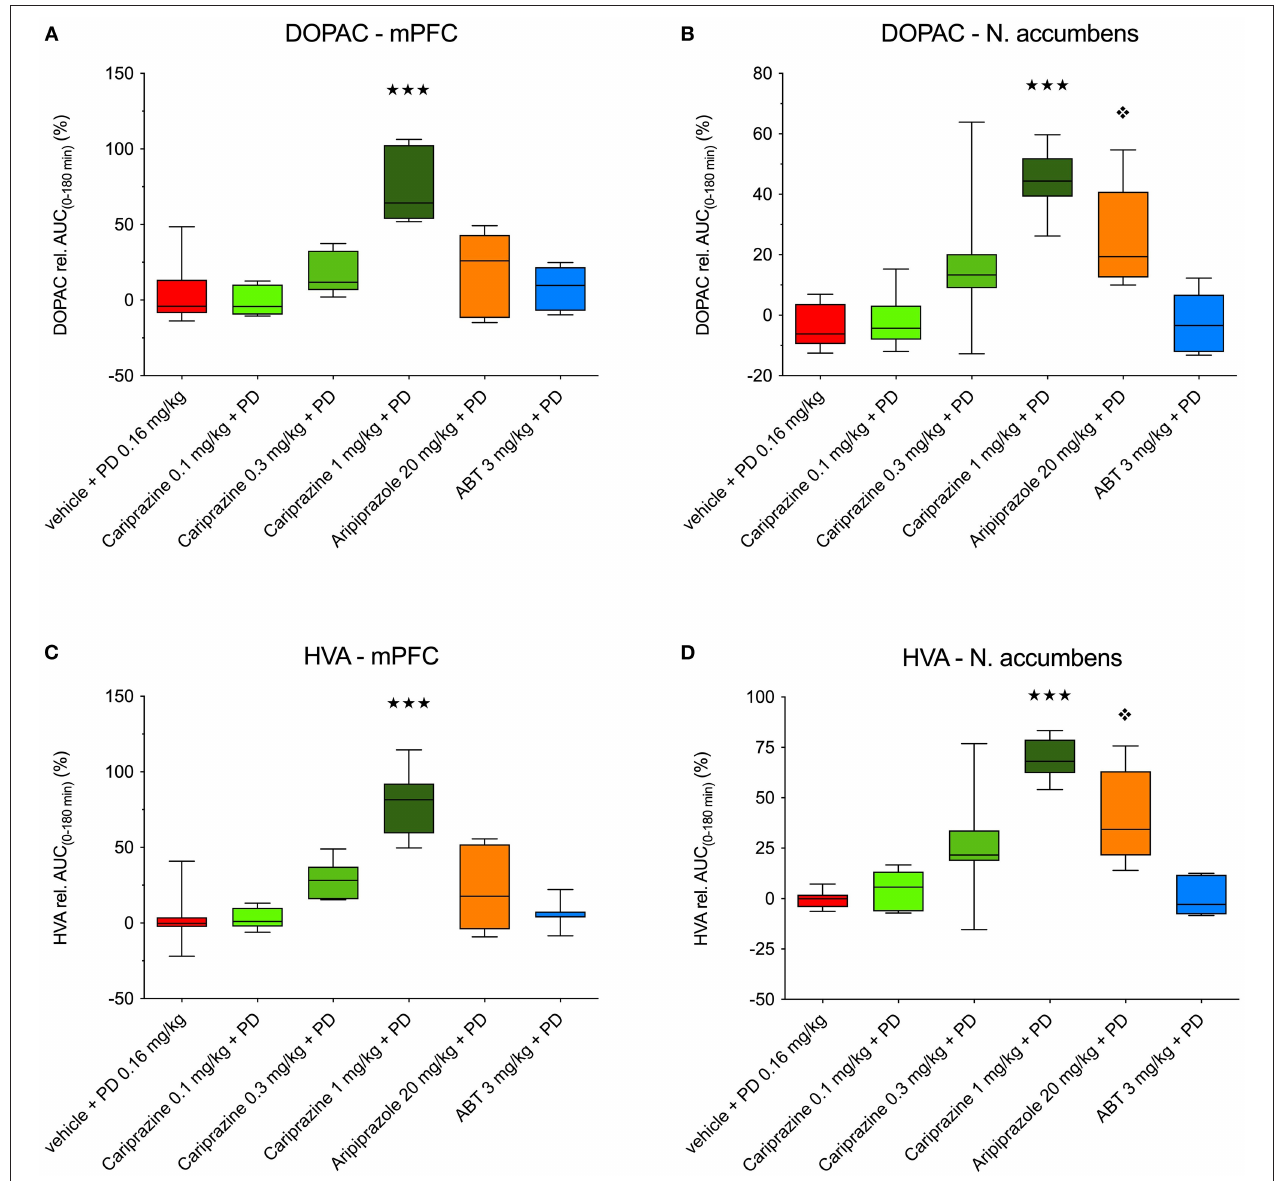
FIGURE 6 | The overall effects of ( + )-PD 128907 and the combined treatment with ( + )-PD 128907 and cariprazine, aripiprazole or ABT-925 on DOPAC (A,B) and HVA (C,D) levels in the mPFC and nAcc shell of the awake rats. ( ) P < 0.001, for cariprazine (1 mg/kg) + PD; ( ) P < 0.05 for aripiprazole + PD; Kruskal–Wallis test followed by Dunn’s multiple comparison test. ABT, ABT-925; PD, ( + )-PD